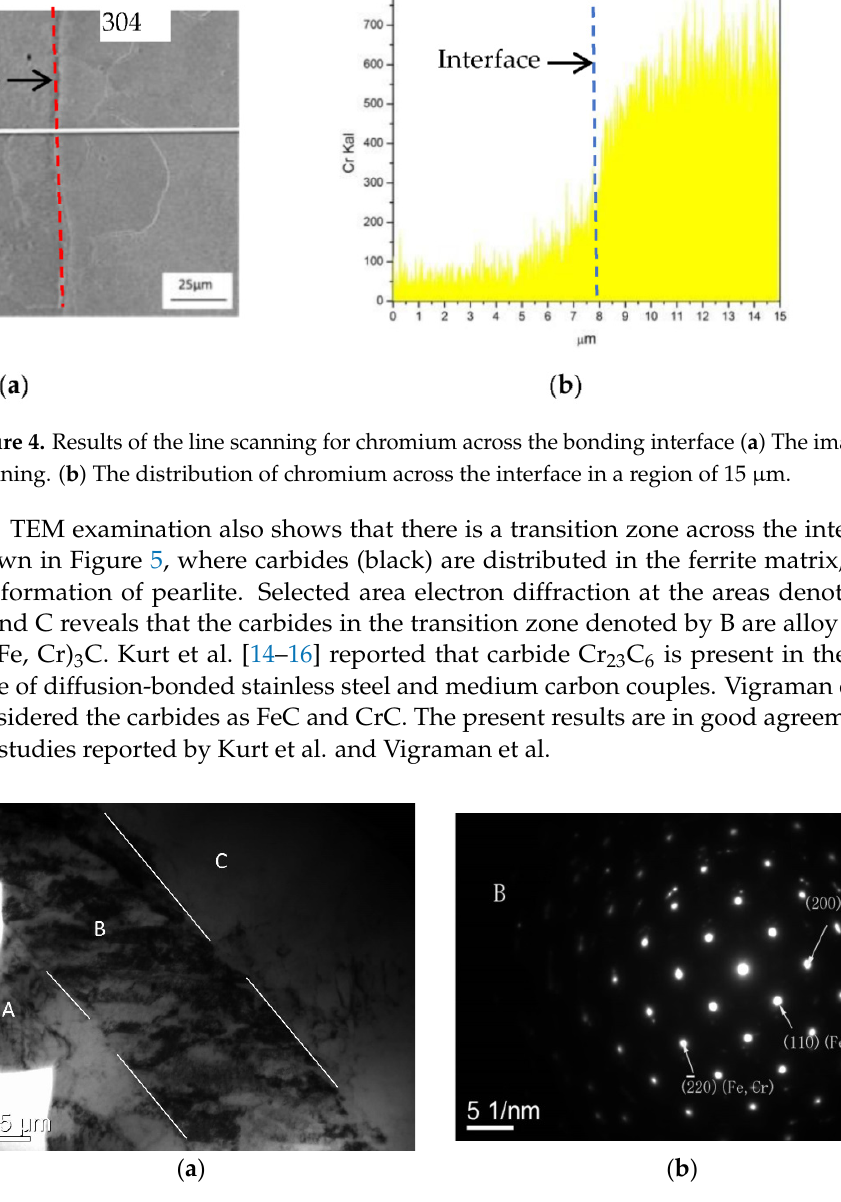
Figure 5. The TEM observation and selected area electron diffraction analysis on the interface: ( a ) the TEM image; ( b ) the selected area electron diffraction pattern of each area at the interface.